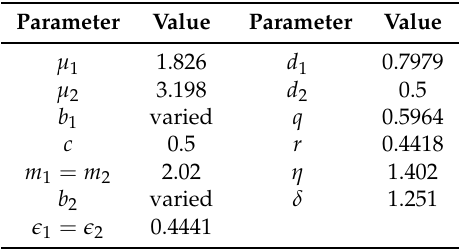
Table 1. The values of the parameters of the model in Equations (9)–(12).